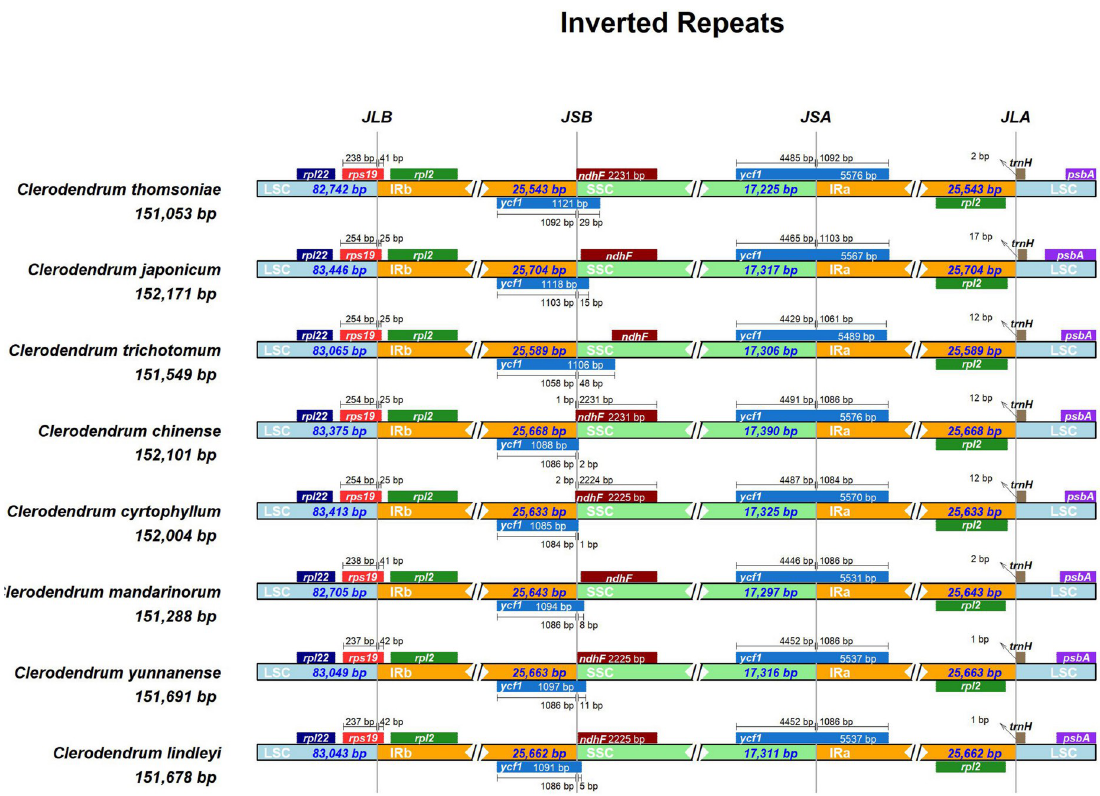
Fig 4. Boundary analysis of the single copy region and inverted repeated region among 8 Clerodendrum species. The name of each species and its corresponding length of chloroplast genome sequence are described on the left side of each track. Genes shown above the lines are transcribed forward while genes shown below the lines are transcribed reversely. Light blue, orange, and green box represent LSC, IR and SSC region, respectively. The numbers on the box indicate the length of each region. The number near the arrow shows the distance between the start or end coordinates of a given gene and the corresponding junction site. JLB (IRb/LSC), JSB (IRb/SSC), JSA (SSC/IRA) and JLA (IRa/LSC) represent the junction between corresponding regions in the genome